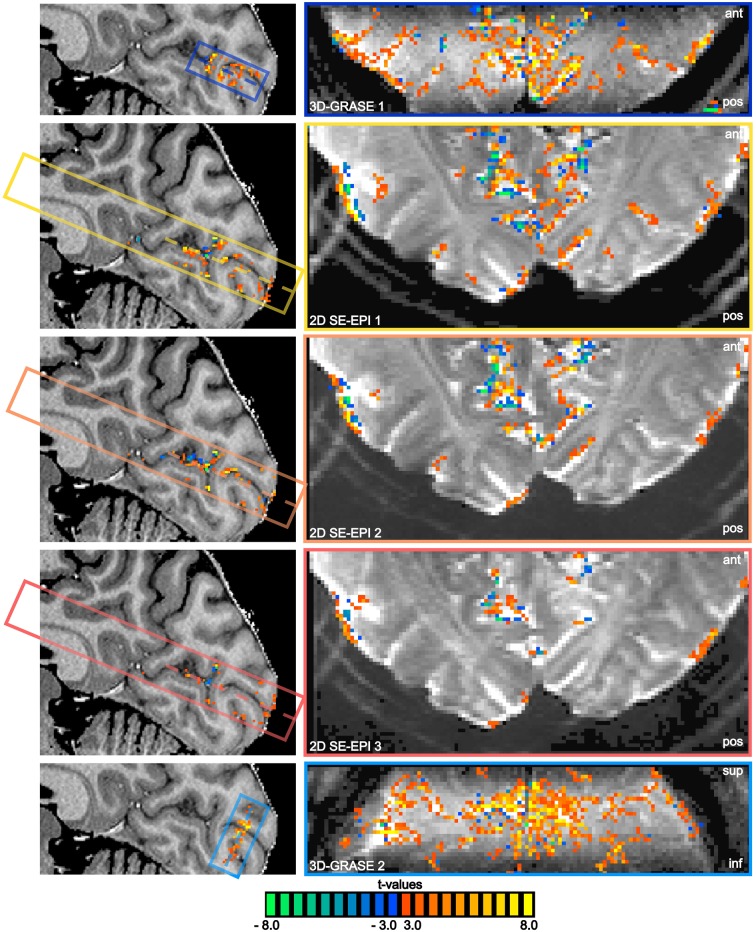
BOLD responses overlaid on anatomical reference and averaged functional slices. Mid-sagittal slices of the reference anatomical scan (left) and central functional slices (right) are shown, as indicated by the dashed lines. Note the oblique coronal orientation of 3D-GRASE 2. The same statistical threshold was applied to all acquisitions (t > 3.0, p < 0.003 two-sided t-test on single voxel level, cluster threshold of 4 voxels). The position of the sagittal cut is shown on a transversal slice in the bottom left corner. The extent and orientation of the functional slices as well as the displayed slice position (dashed lines) are indicated by the colored boxes in the sagittal images.